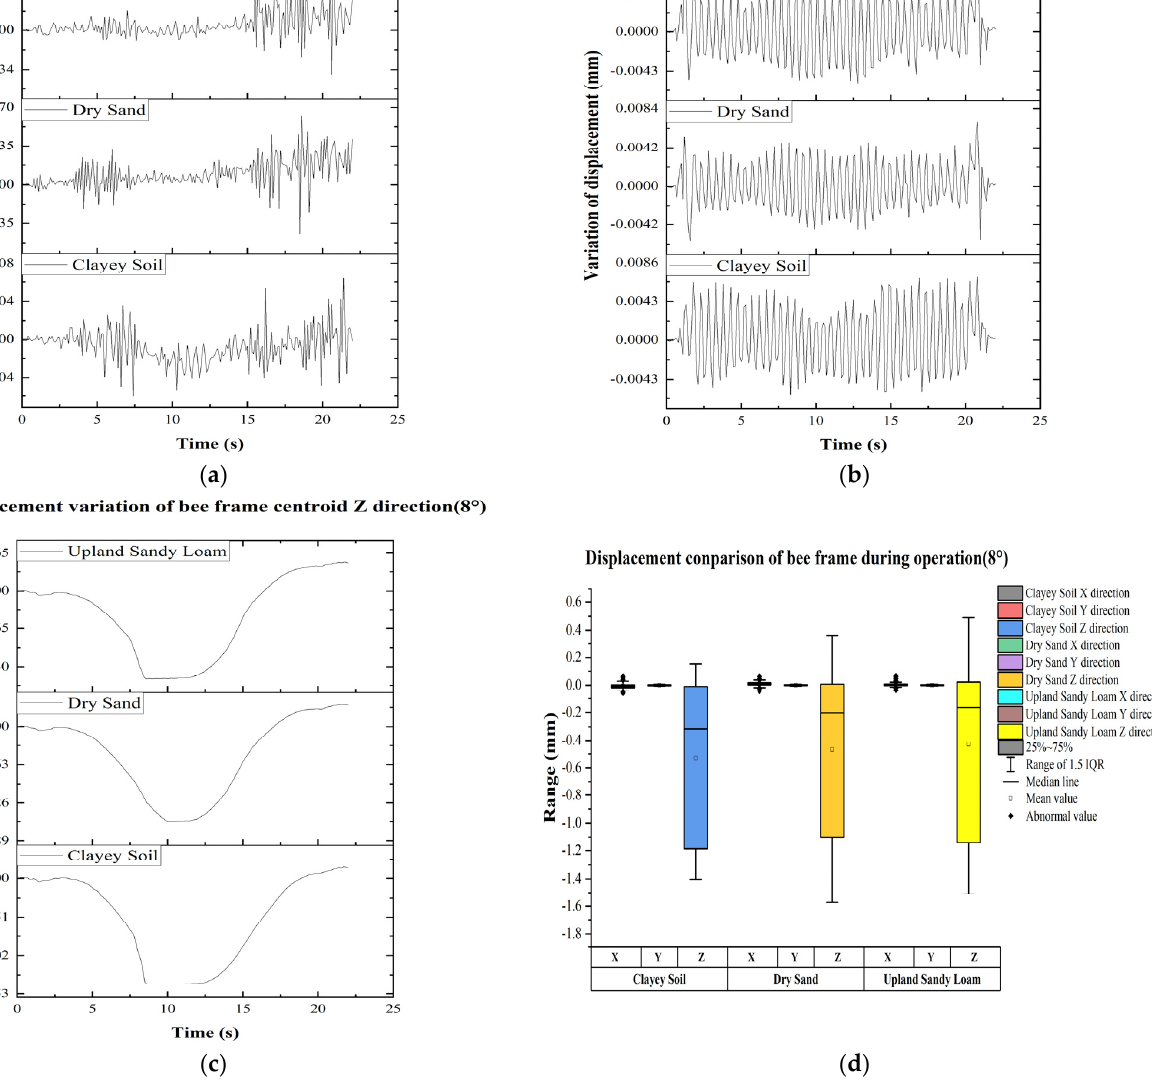
Figure 16. Variation of relative displacement in ( a ) the X-direction of the bee frame (8°), ( b ) Y - direction of the bee frame (8°), ( c ) Z - direction of the bee frame (8°), and ( d ) range of XYZ direction for the bee frame (8°).